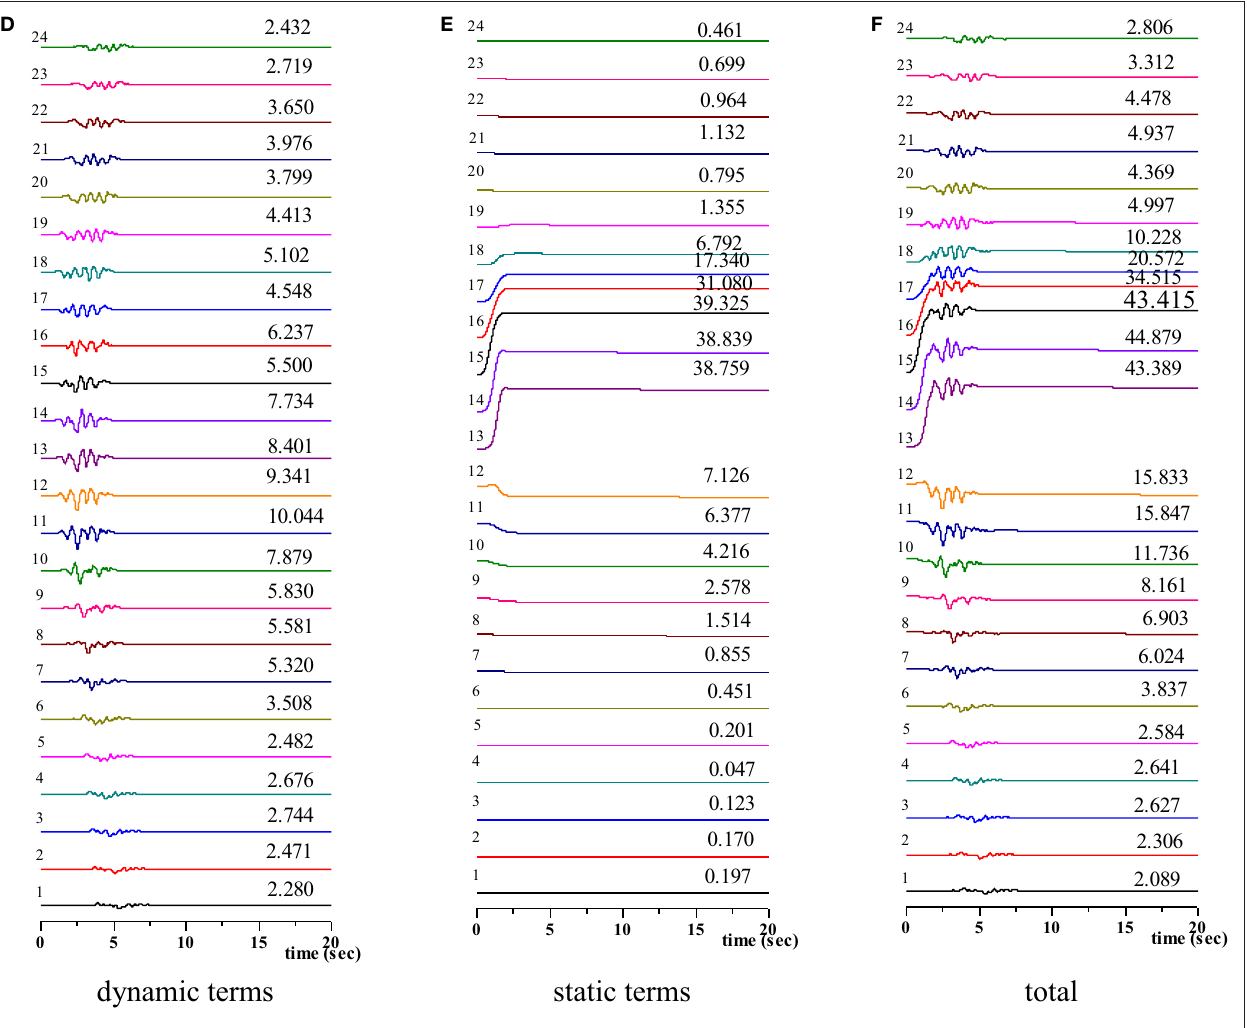
FigUre 11 | simulated time histories of velocity [(a) dynamic terms (B) static terms, (c) total] and displacement [(D) dynamic terms (e) static terms (F) total] along up–down direction (note: the left numbers present the observation point, right numbers present the peak values)